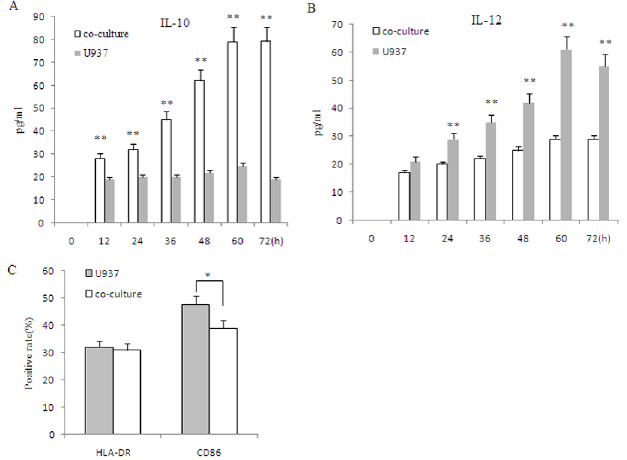
Fig 2. Effect of co-culture on inducing macrophages toward the M2 phenotype. U937 (1×10 5 cells per well of 24 well plates) was stimulated with LPS (10ng/ml) for 24h after undergoing co-culture with eutopic ESCs for 72h, followed by an analysis of the secretion of IL-10 (A) and IL-12 (B) by ELISA. Surface expression of HLA-DR and CD86 in U937 cells was determined by flow cytometry (C). Eutopic ESCs = ESCs from eutopic endometrium with endometriosis. Data are expressed as mean ± SD of independent experiment, performed in triplicate wells with three different samples. * P < 0.05 compared with the U937 control, ** P < 0.01 compared with the U937